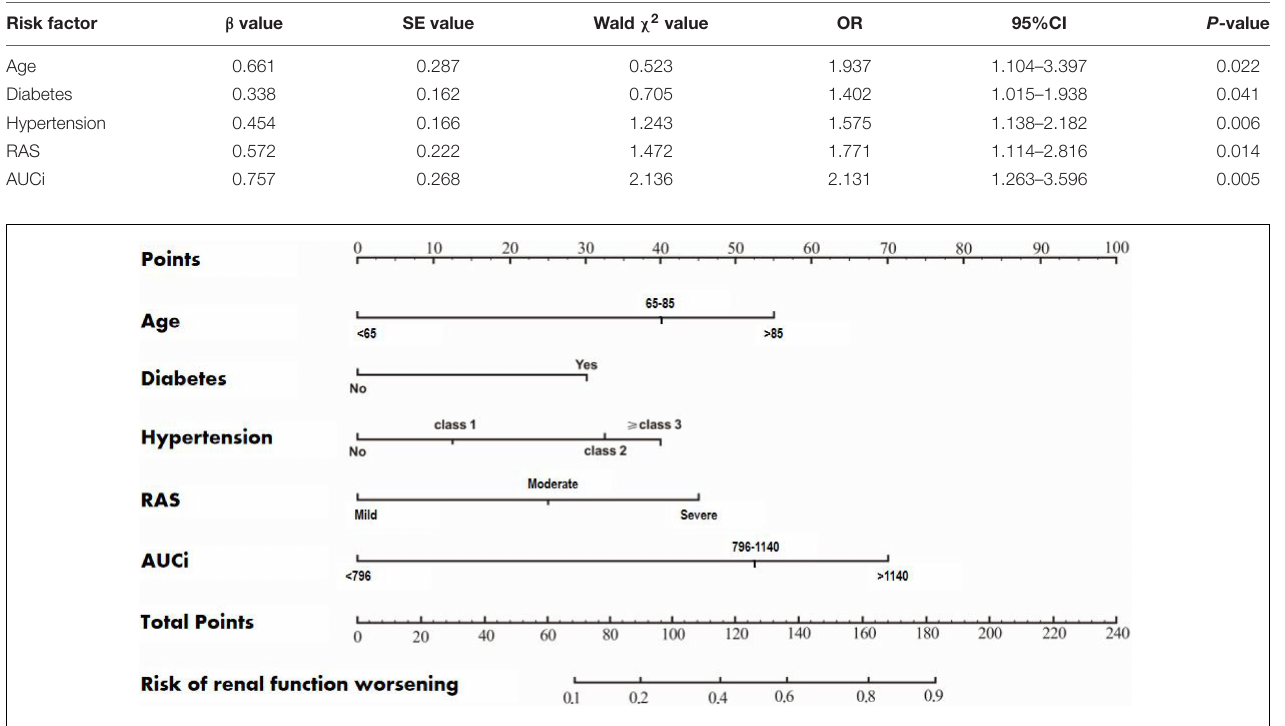
FIGURE 1 | A nomogram of the CEUS+ scoring system for predicting the rate of deterioration of renal function during the 1-year follow-up.